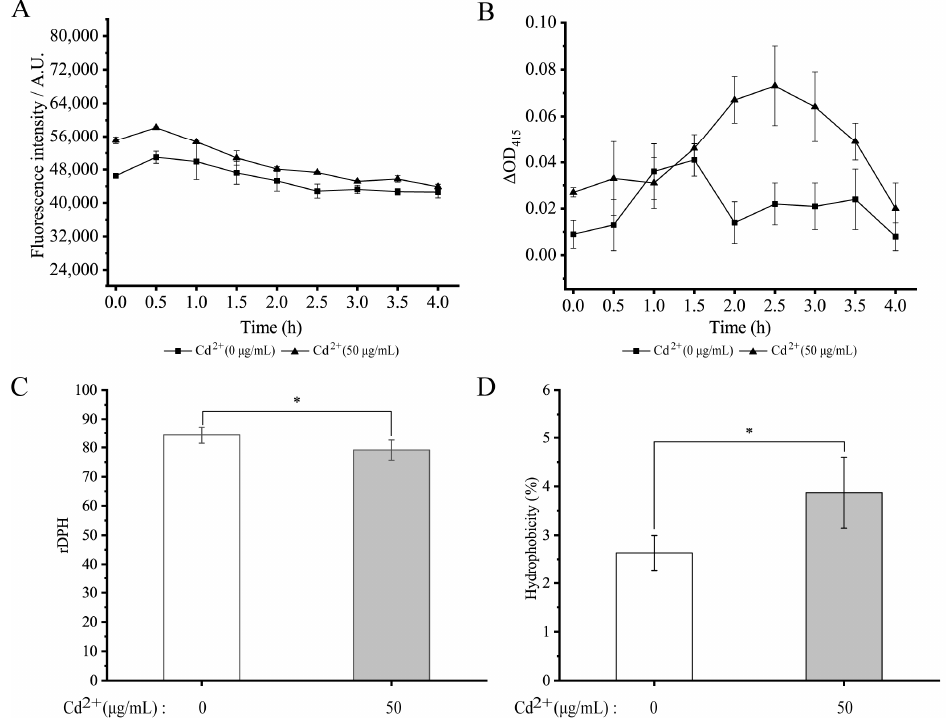
Figure 6. The changes in cell membrane permeability and fluidity and cell surface hydrophobicity of V. parahaemolyticus N10-18 under the Cd 2+ (50 μ g/mL) stress. ( A – D ) The outer and inner membrane permeability, membrane fluidity, and cell surface hydrophobicity, respectively. * p < 0.05.